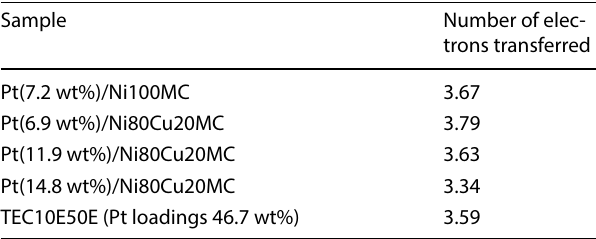
Fig. 6 The ring electrode currents of rotating ring-disk electrode voltammetry for the oxygen reduction reaction in an O -saturated 0.1-M HClO 2 solution over the samples shown in Table 2. The scan rate is 10 mV/s at 900 rpm. The results obtained from Pt-loaded MCs as Pt(7.2 wt%)